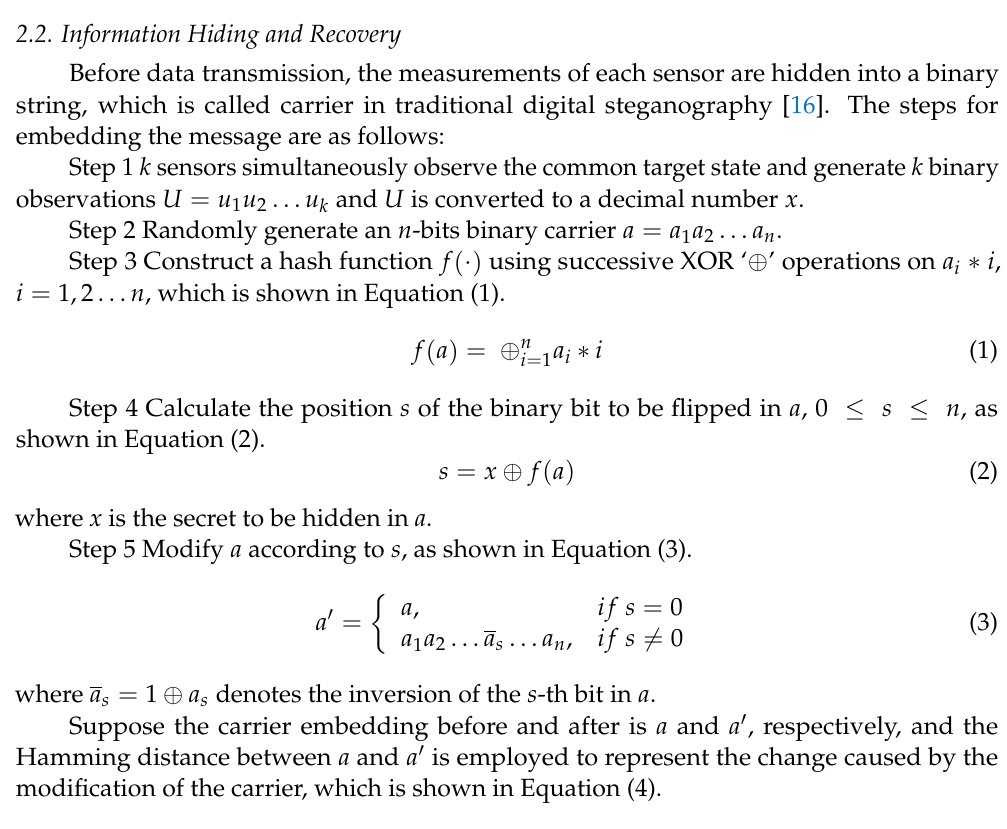
Figure 2. The main process of the proposed scheme.